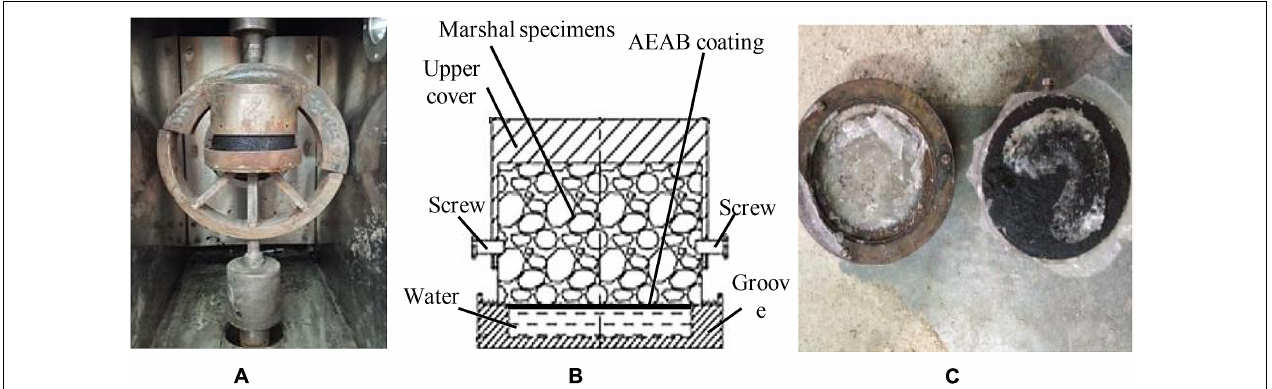
FIGURE 1 | The asphalt pavement brushed with AEAB.